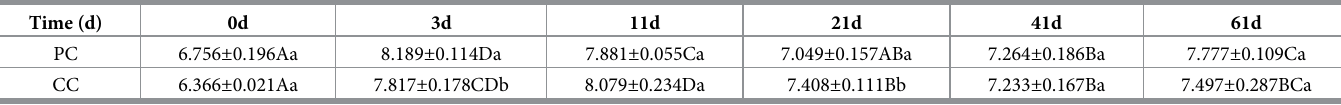
Data in the table were the mean ± S.D. of three fermented sausage per experimental group of three independent experiments. Different capital letters indicated significant differences over time within the same group ( P < 0.05) and different lowercase letters indicated significant differences between groups at the same time ( P < 0.05), while the same letter indicated no significant difference ( P >